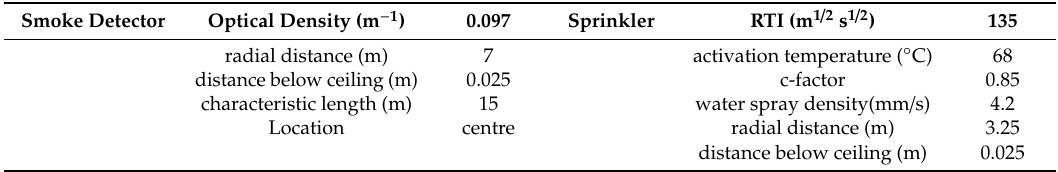
Table 7. Inputs for the ASET / RSET